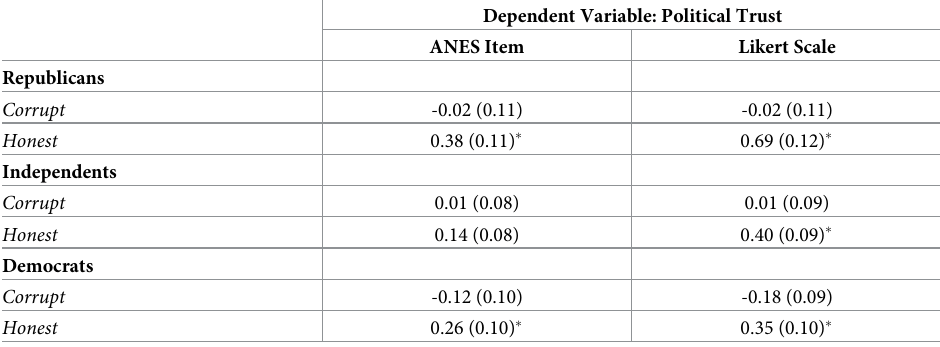
Table 3. Estimated treatment effects and standard errors by party identification and outcome measure.